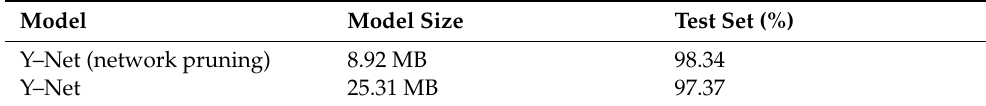
Table 3. The results of network